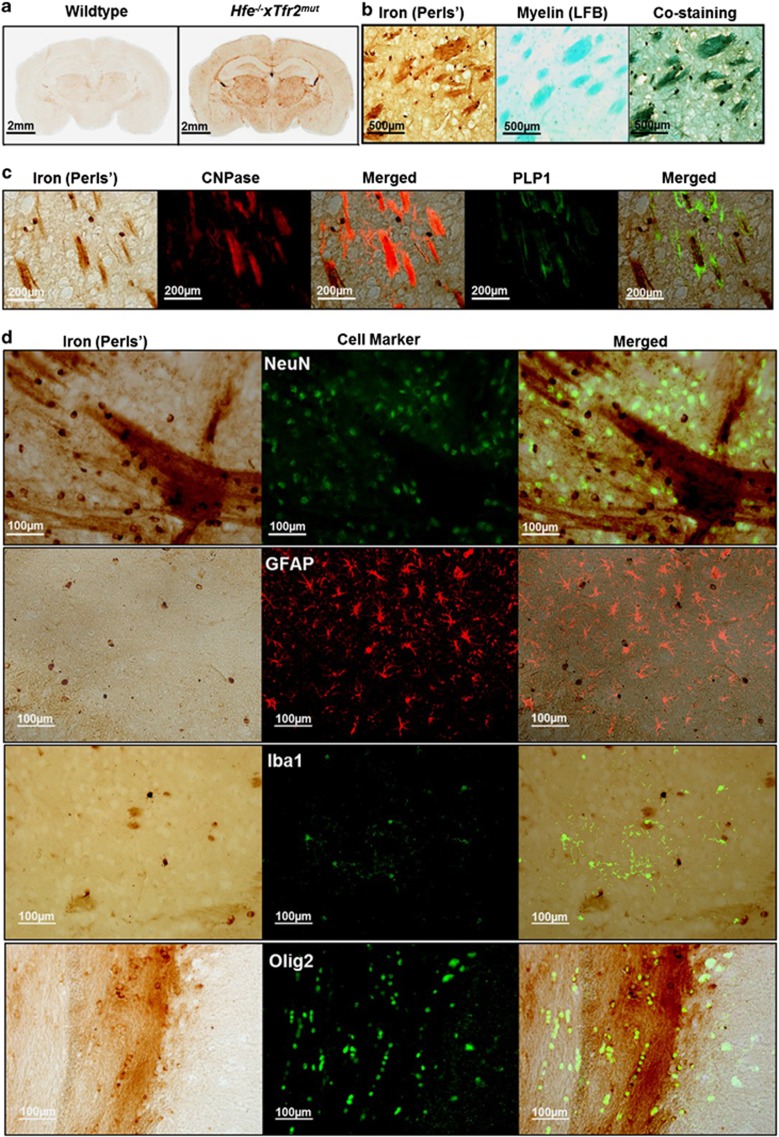
(a) Iron distribution in wild-type and Hfe−/−
× Tfr2mut mouse brain at 3 months of age by 3,3′-diaminobenzidine (DAB)-enhanced Perls' staining. Iron is predominantly localized to myelinated areas throughout the brain, including the corpus callosum and deep white matter of the basal ganglia. (b) Colocalization of staining for iron and Luxol Fast Blue (LFB) staining for myelinated patches in adjacent coronal sections of Hfe−/−
× Tfr2mut caudate putamen. (c) Colocalization of iron and myelin tracts immunolabeled with 2′,3′-cyclic nucleotide 3′-phosphodiesterase (CNPase) or proteolipid protein 1 (PLP1). (d) Colabeling of iron with immunolabeling for neurons (NeuN), astrocytes (GFAP), microglia (Iba1) and oligodendroglia (Olig2). Digitally merged images show iron staining colocalizes with some but not all Olig2-positive oligodendroglia but few if any of the other cell types examined.